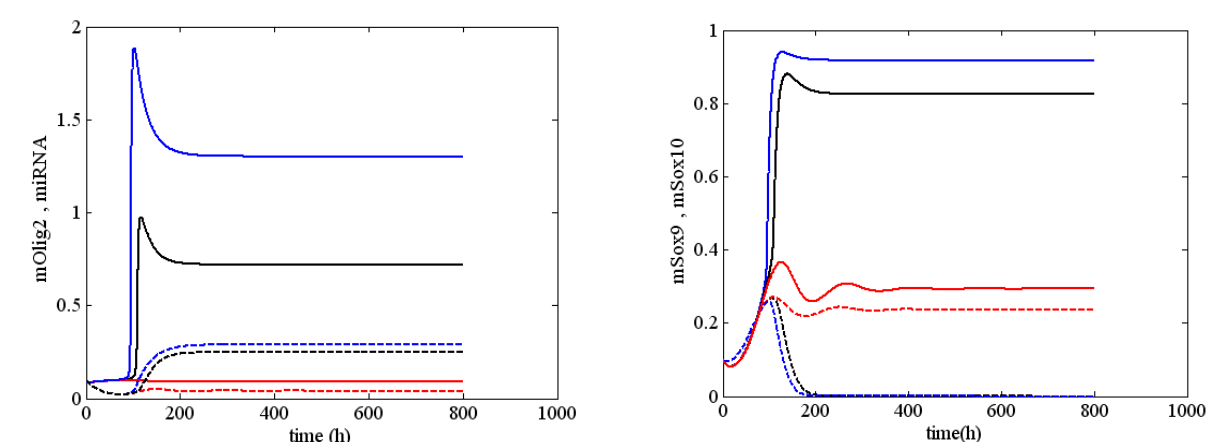
Figure A1. Sketch of the system’s bistability structure in case of 0 marks the boundary of bistability between two stable equilibria (fixed points). Red points and ar- rows are stable; Blue point and arrows are unstable.